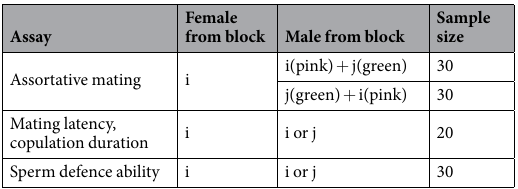
Table 1. Mating treatments for different assays. The letters i and j denote block (replicate) numbers, i ≠ j (in a round robin way). All mating trials were conducted within a selection regime.